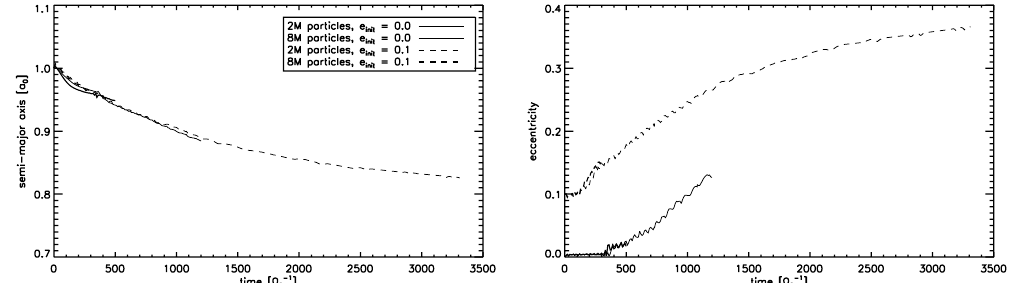
Figure 2. Evolution of the binary orbit elements a (left panel) and e (right) for di ff erent simulations. Solid lines show runs with the binary in an initially circular orbit, while dashed lines show binaries with e = 0 . 1 initially. In both cases the eccentricity grows, and the orbital decay proceeds at the same rate. Figures from Cuadra et al